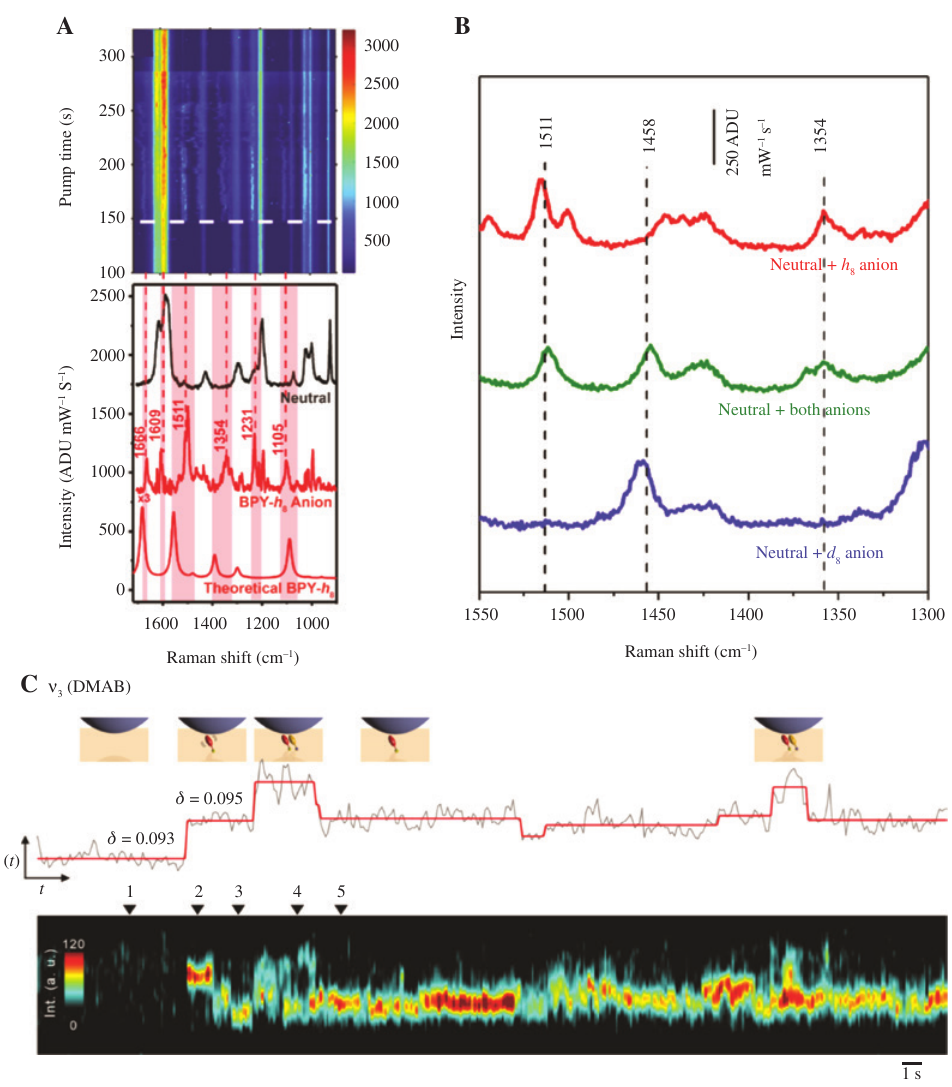
Figure 6: Time-dependent single-molecule SERS. (A and B) Anion formation event for BPY on a Au nanoantenna substrate with the associated isotopologue analysis to confirm single- molecule limit and (C) single-molecule step transitions after the formation of DMAB in real time. (A and B) Reprinted with permission from Ref. [108]. Copyright 2017 American Chemical Society. (C) Reprinted with permission from Ref. [109]. Copyright 2016 American Chemical